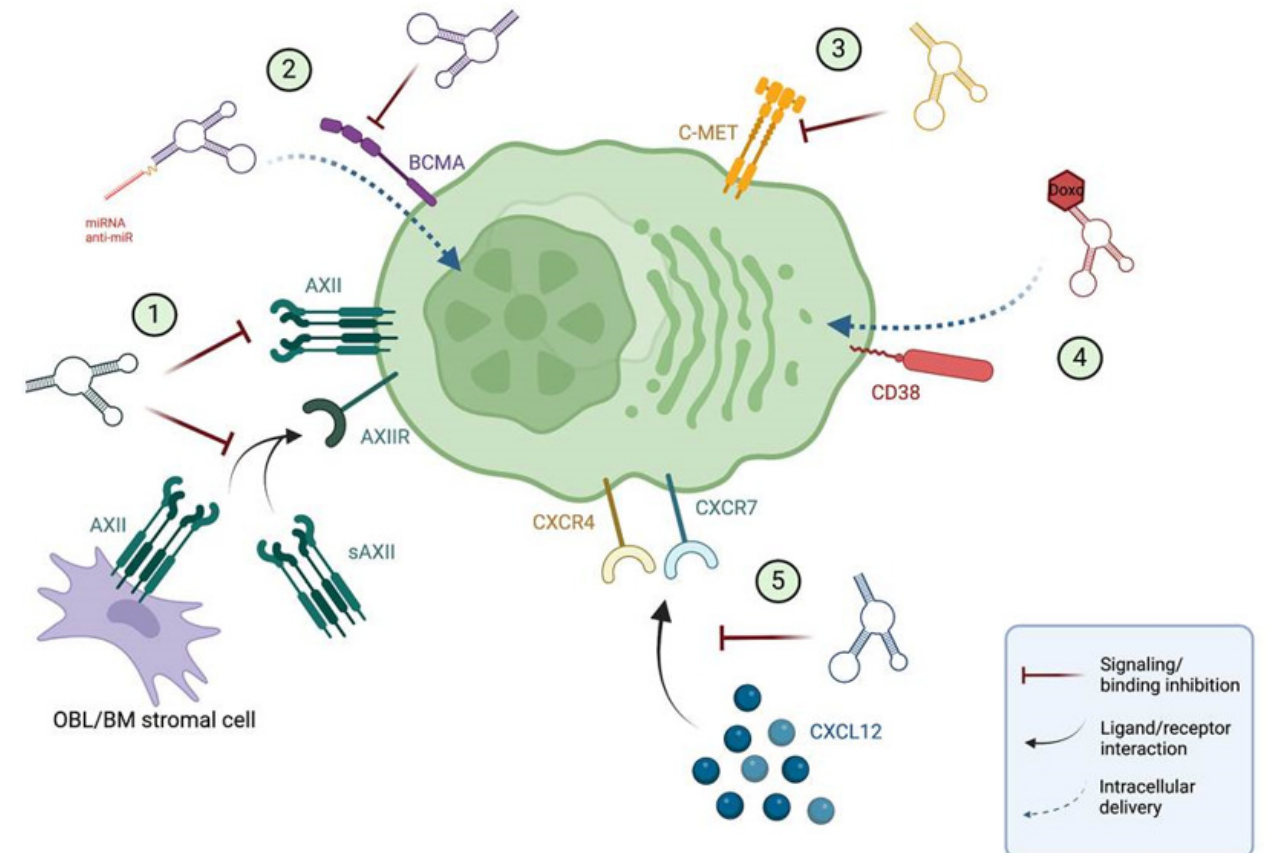
Figure 2. Current aptamers for precision medicine in MM. ( 1 ) Aptamer against AXII, ( 2 ) BCMA targeted aptamer, ( 3 ) aptamer against C-MET, ( 4 ) conjugated CD38-doxorubicin aptamer and ( 5 ) NOX-A12 RNA aptamer for CXCL12. All the aptamers except the NOX-A12 spiegelmer are directed towards receptors expressed in the MM plasma cell membrane. Receptor–ligand interactions are depicted with black arrows, while the mechanism of action of aptamers is depicted with red arrows for antagonist aptamers, and blue arrows for cargo delivery aptamers. BM: bone marrow; Doxo: doxorubicin; OBL: osteoblast; sAXII: soluble annexin A2. Image made in ©BioRender.